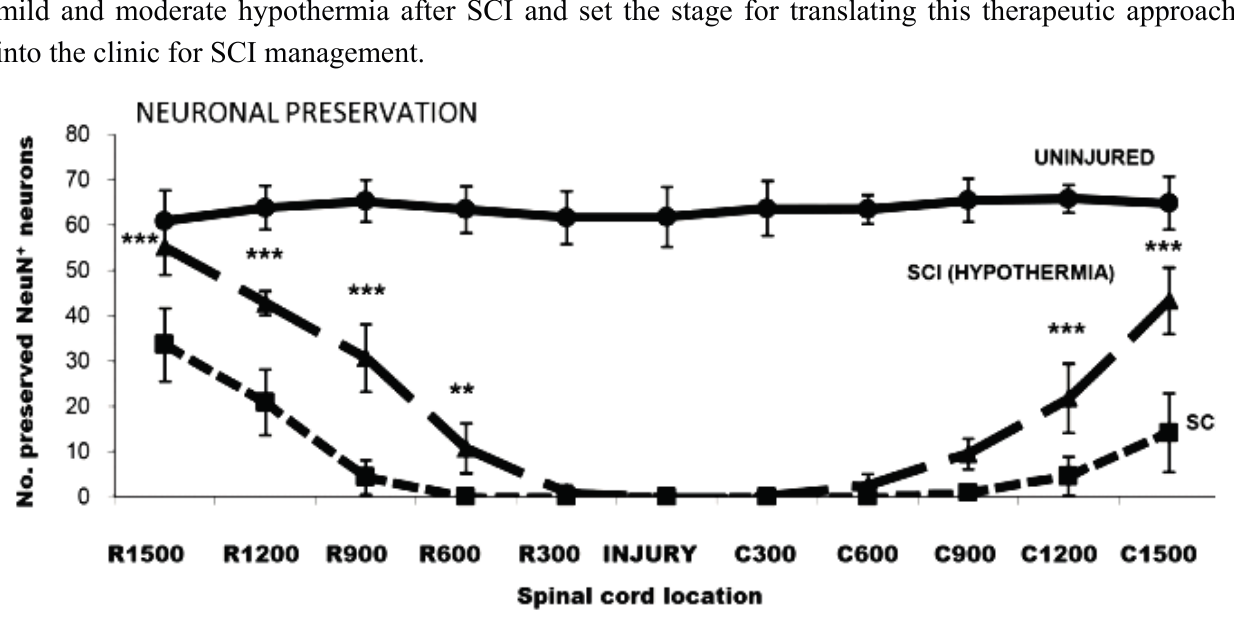
Figure 2. Hypothermia increased the numbers of preserved ventral motor neurons rostral and caudal to the injury site at 10 weeks post cervical spinal cord injury (SCI). Counts of cells labeled for NeuN (a neuron-specific marker) from transverse sections rostral (R) and caudal (C) to and within the injury epicenter of the cervical cord showed that acute application of mild systemic hypothermia could significantly increase the numbers of NeuN-immunoreactive neurons in the ventral horn (laminae VII–IX) at distances of 900 µm and greater from the injury epicenter compared with normothermic controls. Almost no preserved ventral motor neurons, however, were detected within the immediate injury site in both SCI groups. Recordings from uninjured controls are provided for comparison, and the data are expressed as the average ± standard error of the mean. *** p < 0.001, ** p < 0.01 compared with normothermic controls. Reprinted with permission from [42], copyright Wiley-Liss, Inc.,